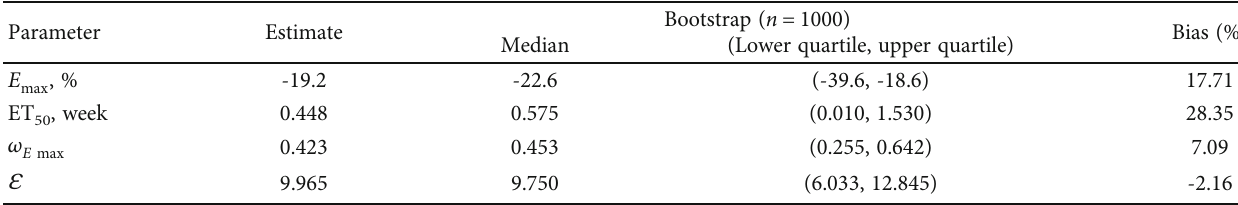
Figure 4: Visual predictive check plots. Median, 10% CI and 90% CI were simulated by Monte Carlo ( n = 1000 ); CI: con fi dence interval. a-h were from studies [16 – 21]. Table 1: Parameter estimates of fi nal model and Bootstrap.